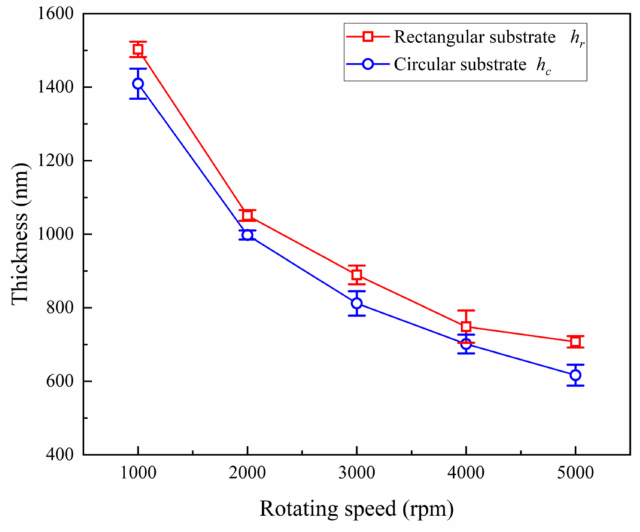
Figure 5. Comparison of experimental results on circular rectangular plates at different rotating